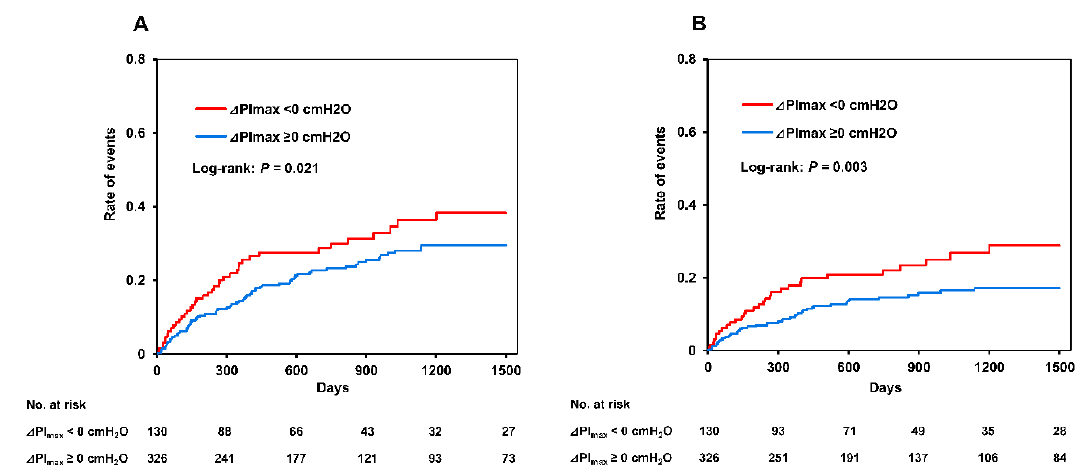
Figure 1. Kaplan–Meier survival curves of the association between change in respiratory muscle strength and clinical events. ( A ) All-cause events and ( B ) cardiovascular events; Red line, patients with ⊿ PI max < 0 cmH 2 O; blue line, patients with ⊿ PI max ≥ 0 cmH 2 O. PI max , maximal inspiratory pressure.